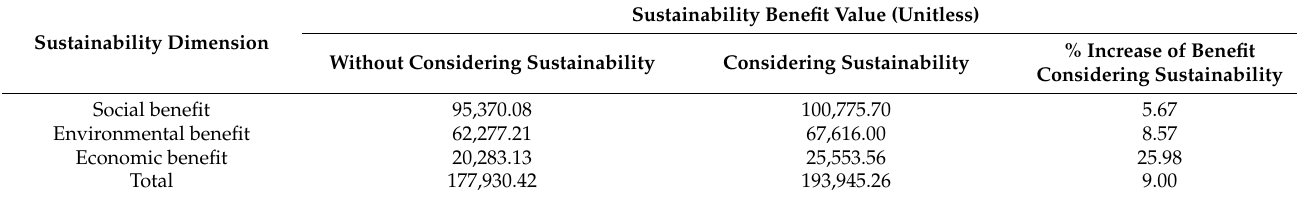
Table 6. Sustainability benefit values of optimal land allocation.